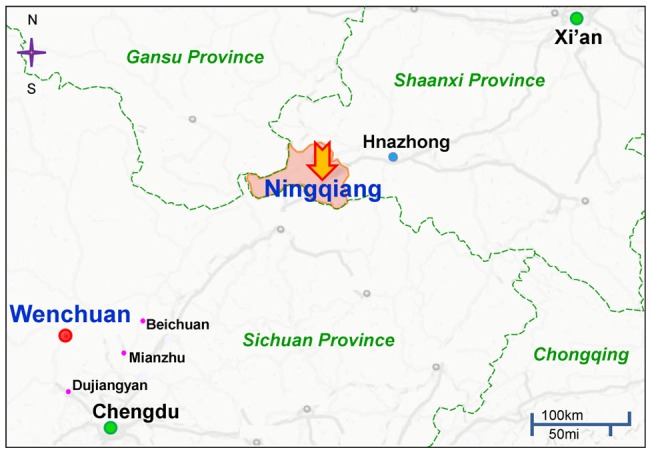
Geographical location of the Ningqiang study cohort relative to the 2008 Wenchuan Earthquake in China.Chengdu and Xi'an are the capital of the Sichuan province and Shaanxi province, respectively. The epicenter Wenchuan is 80 kilometers west-northwest of Chengdu. Ningqiang located in the southwest of the Shaanxi province is the nearest town in the Shaanxi province to the epicenter (Wenchuan).